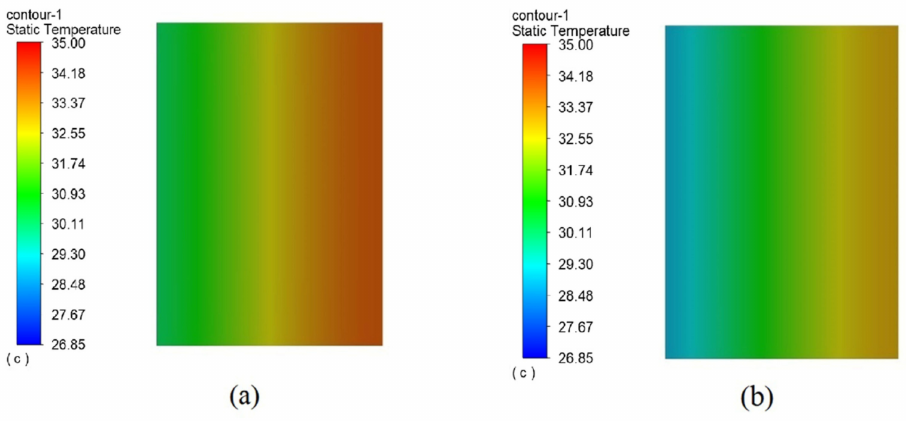
Figure 5. Temperature distributions of battery: ( a ) 10 PPI aluminium foam with 0.918 porosity, ( b ) 10 PPI aluminium foam with 0.682